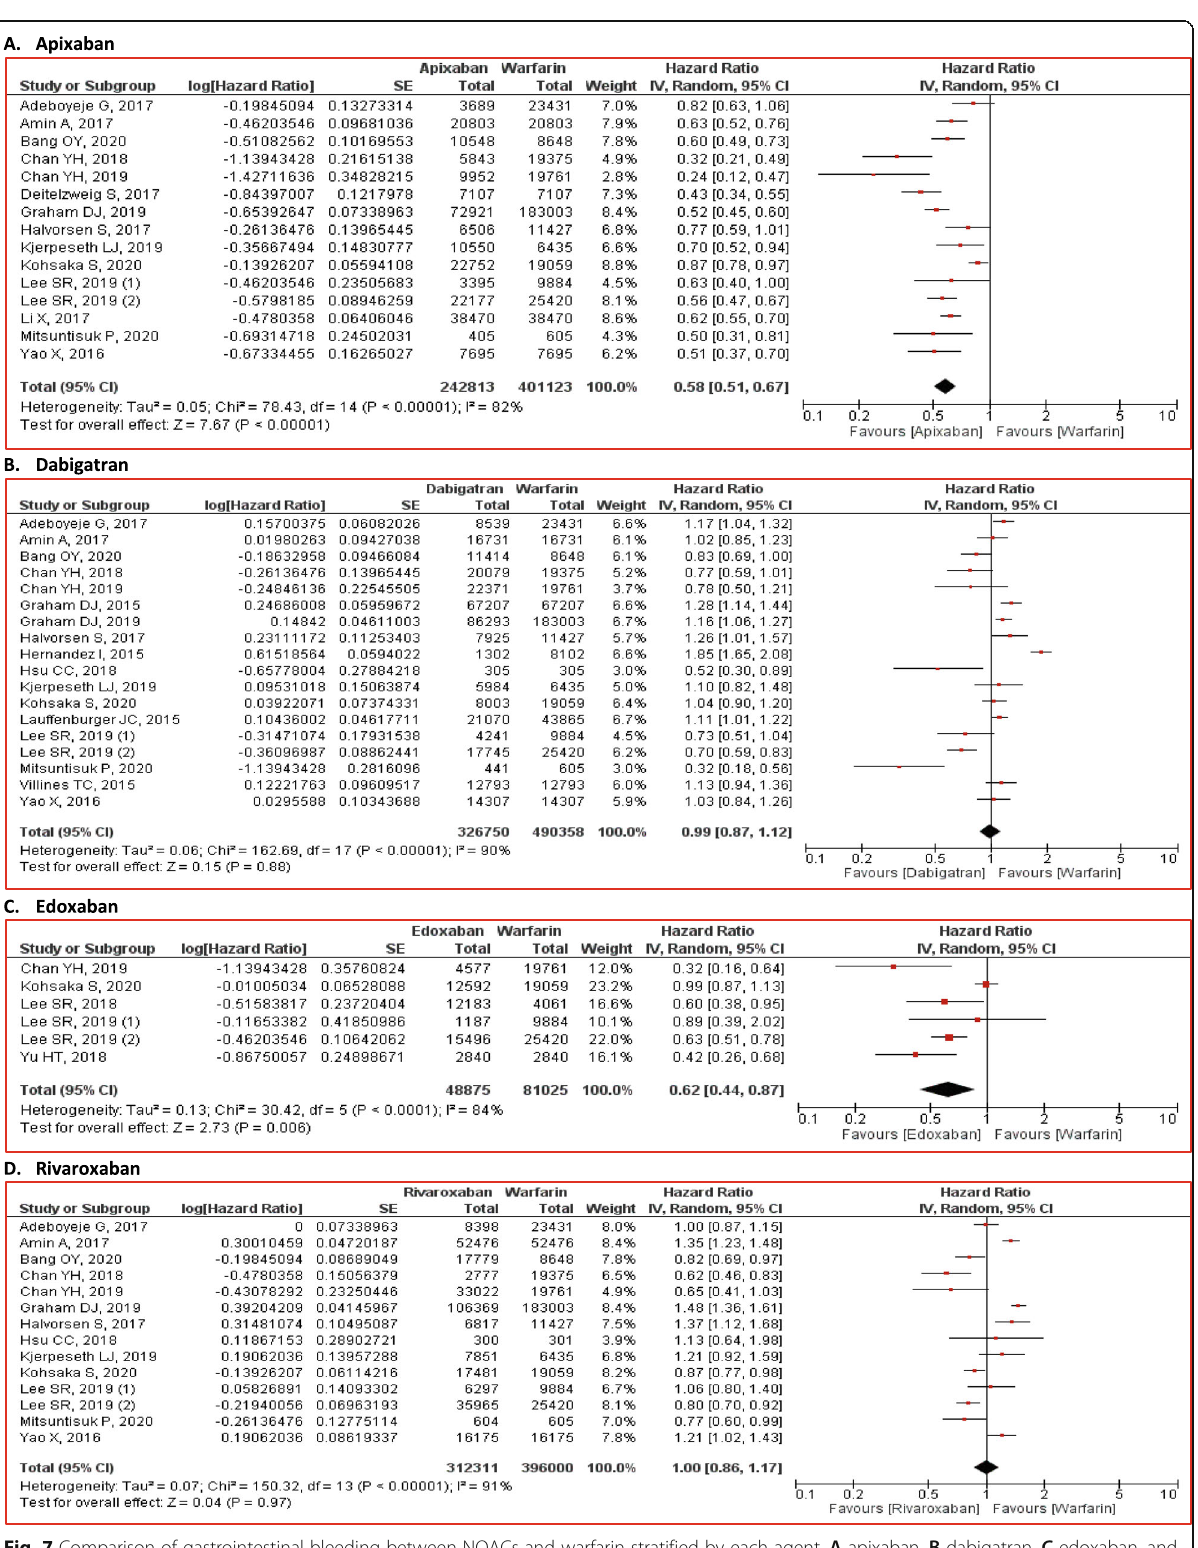
Fig. 7 Comparison of gastrointestinal bleeding between NOACs and warfarin stratified by each agent. A apixaban, B dabigatran, C edoxaban, and D rivaroxaban. CI = confidence interval, NOACs = non-vitamin K antagonist oral